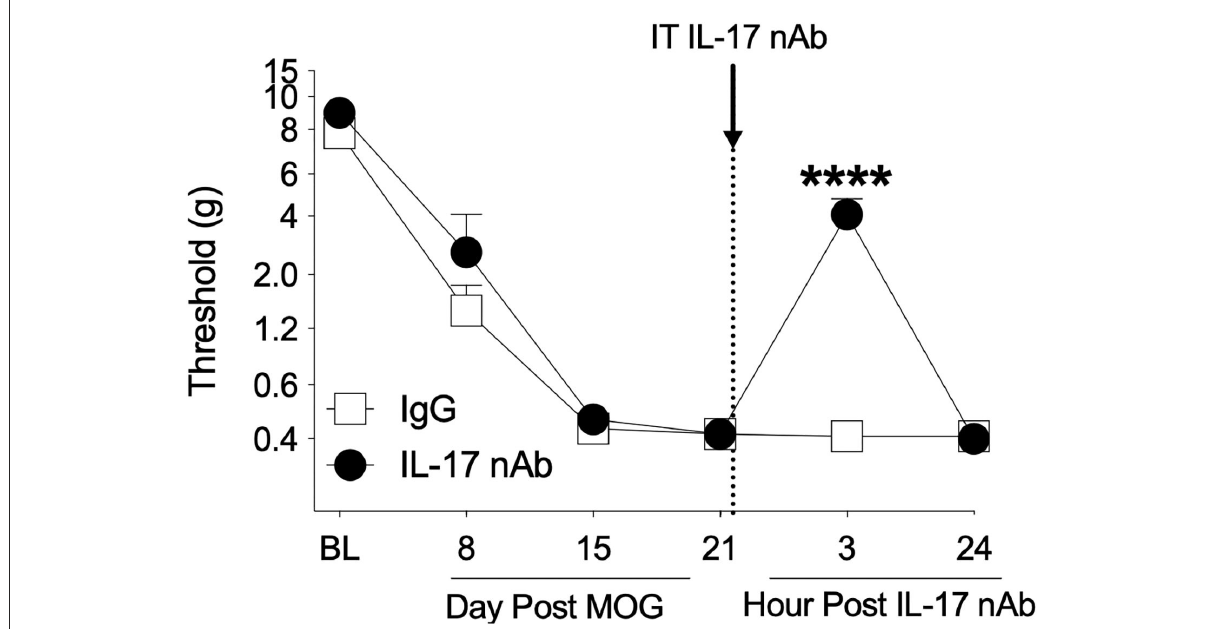
FIGURE6 Intrathecal administration of interleukin-17 neutralizing antibodies (IL-17 nAb) reverses EAE-related pain in Sprague-Dawley (SD) rats. Sprague-Dawley (SD) rats were baselined (BL) for mechanical withdrawal thresholds via the von Frey test, followed by intradermal low-dose (8 µ g) myelin oligodendrocyte glycoprotein (MOG). Approximately 4 µ g of Interleukin-17 neutralizing antibodies (IL-17 nAb) or IgG control was intrathecally administered (see dotted line/arrow indicating time of drug delivery), and allodynia was assessed prior to and at 3 and 24h post-IL-17 nAb delivery. Intrathecal administration of IL-17 nAb reversed EAE-induced mechanical allodynia at 3h but not 24h post-administration. Main effects of day [ F (5, 70) = 142.5; p < 0.0001], IL-17 nAb [ F (1, 14) = 19.57; p < 0.001], and interaction between day and IL-17 nAb [ F (5, 70) = 17.48; p < 0.001]. N = 8/group. Post-hocs : **** indicates significant differences between saline control and each dose of IL-17